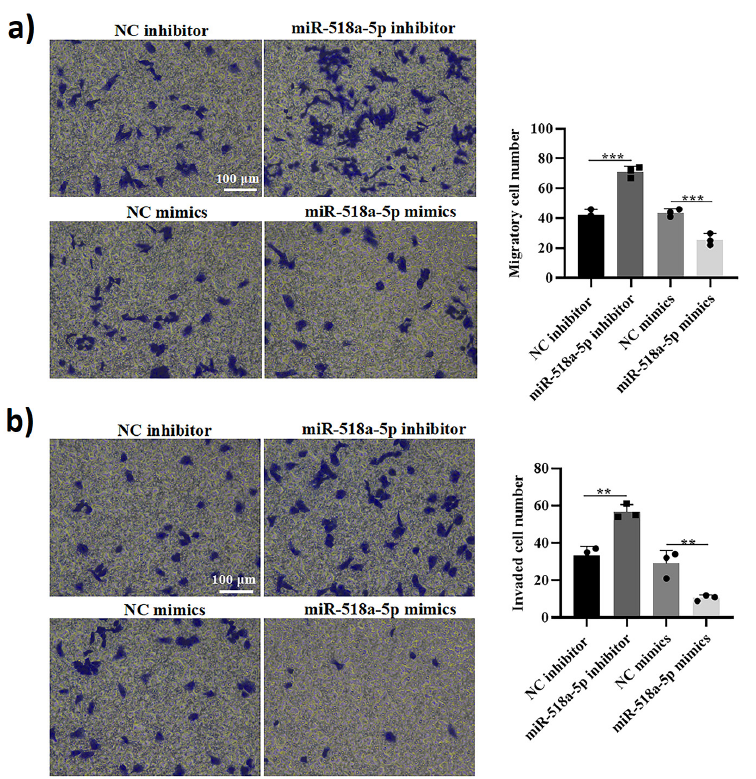
Figure 3. MiR-518a-5p is a negative regulator of HTR8/ SVneo cell migration and invasion. a) and b) Migration and invasion of HTR8/SVneo cells after treatment of miR- 518a-5p mimics or inhibitor were revealed using Transwell inserts that were pre-coated Matrigel or not. One way ANOVA followed by Tukey’s post hoc test was performed. **p<0.01, ***p<0.001. N = 3 for each